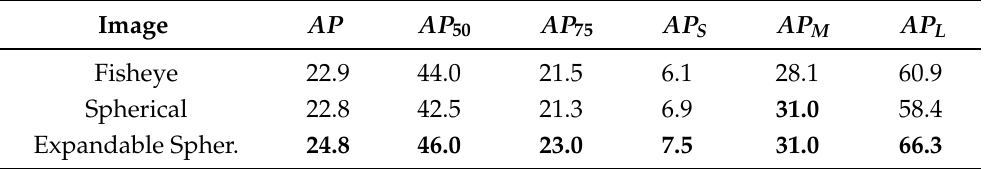
Table 8. Accuracy of different projections of SLCat model on the Fisheye-CityScape.